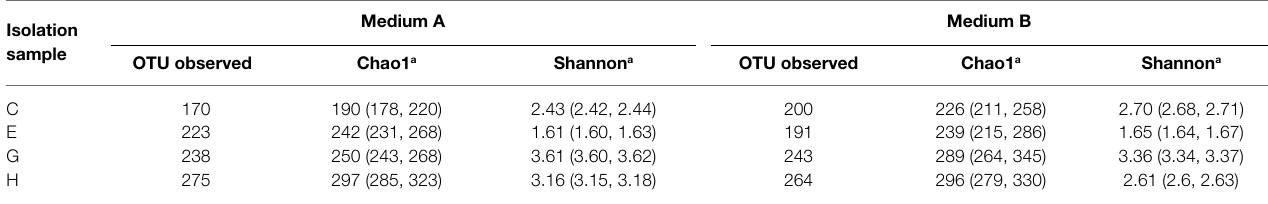
TABLE 1 | Richness and diversity indexes of the bacteria recovered from algal samples with 1,3-xylan based on 16S rRNA gene amplicon